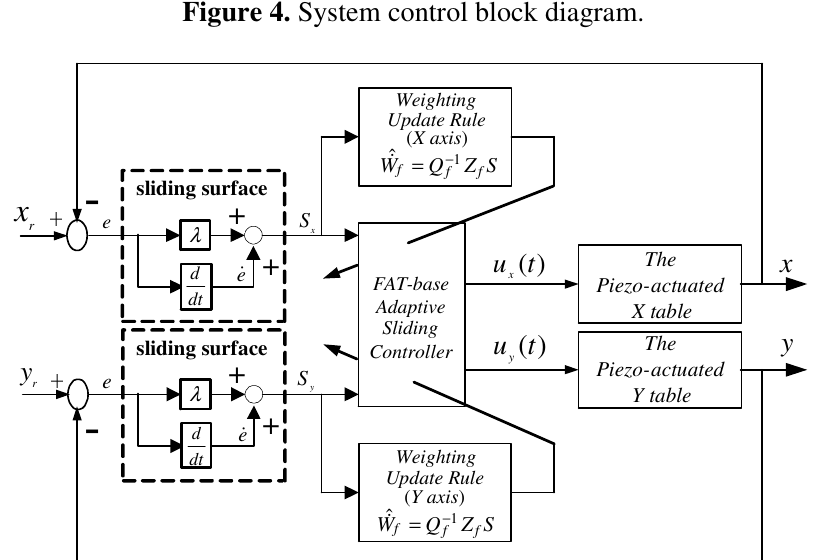
Figure 4. System control block